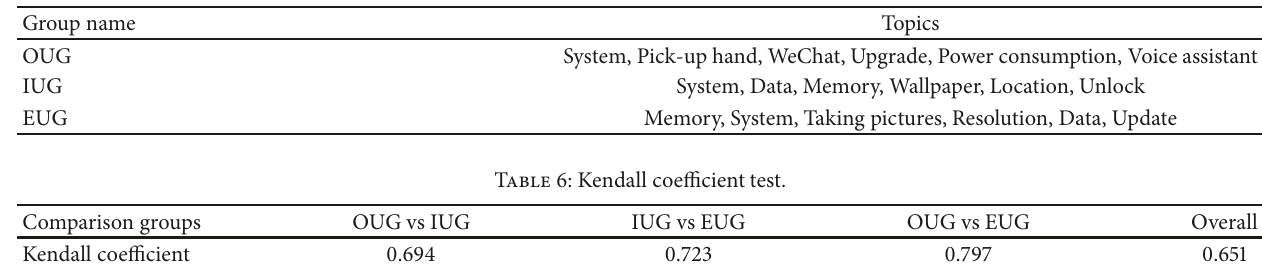
Table 5: “Leaders” of three networks.